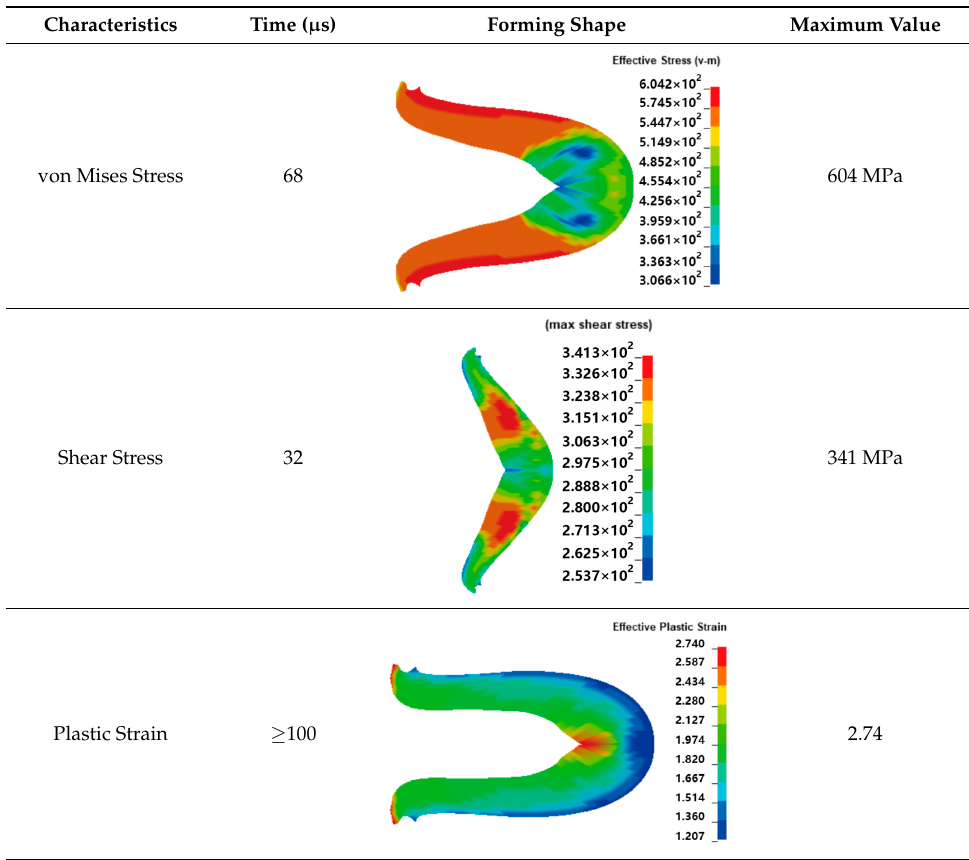
Figure 9. Effective stress of the copper EFP at typical time after detonation. Table 7. Maximum stress and strain conditions in the forming of the Copper EFP.